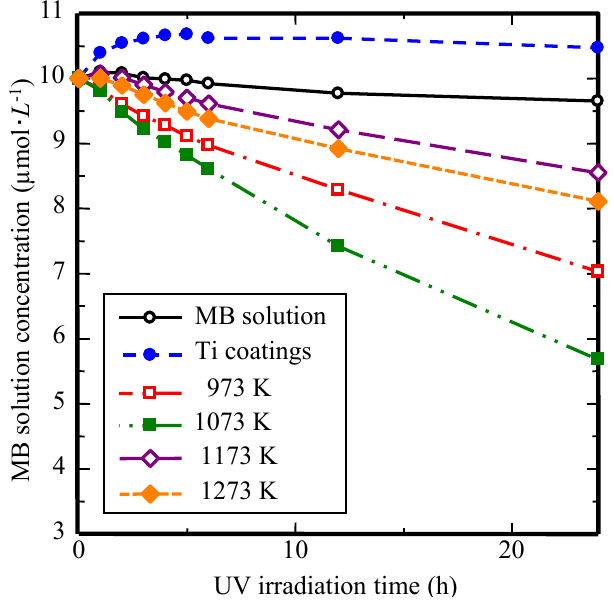
Figure 39. Degradation rate constant of M10- x K-yh samples.